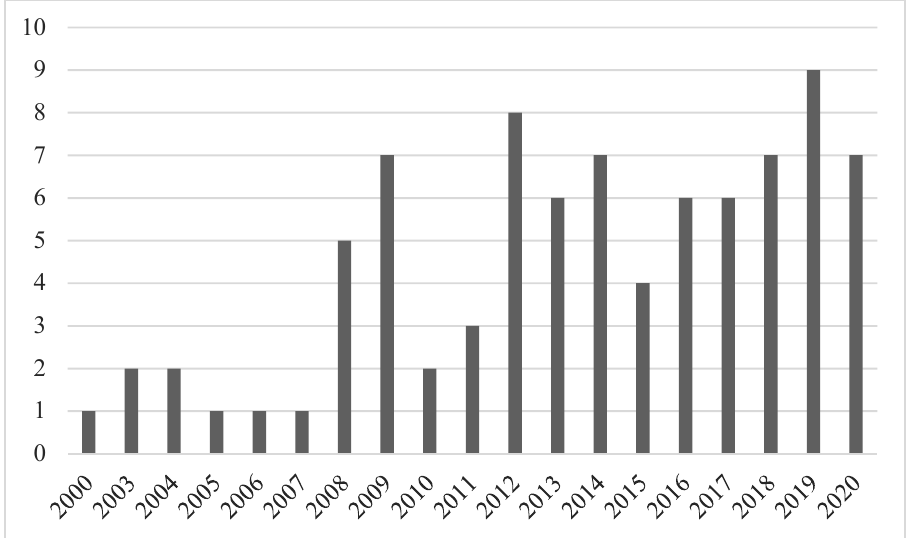
Figure 2. Number of articles by year of publication.